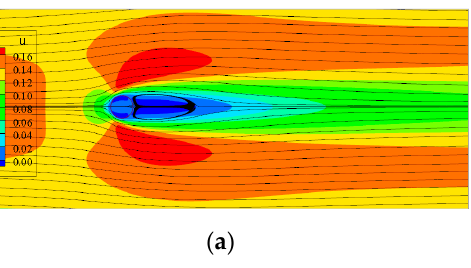
Figure 9. The flow field and streamline around a cylinder. ( a ) Re = 40; ( b ) Re = 100. Table 1. Comparison of related parameters in flow around